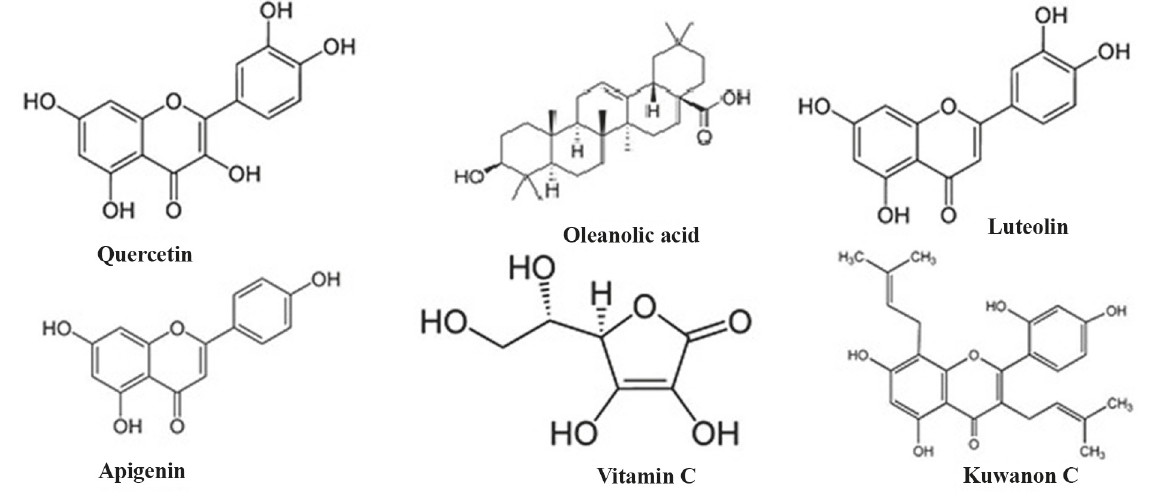
FIGURE 2 - Chemical structure of identified compounds in n -hexane extract of leaves of Morus nigra.